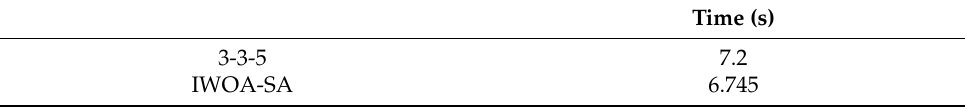
Table 7. Time comparison before and after using the optimization